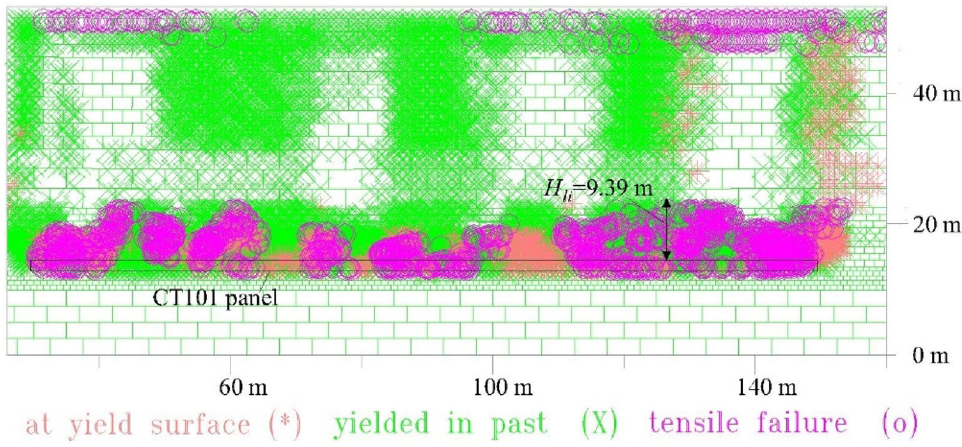
Fig. 4 Distribution of the failure zone based on numerical simulation